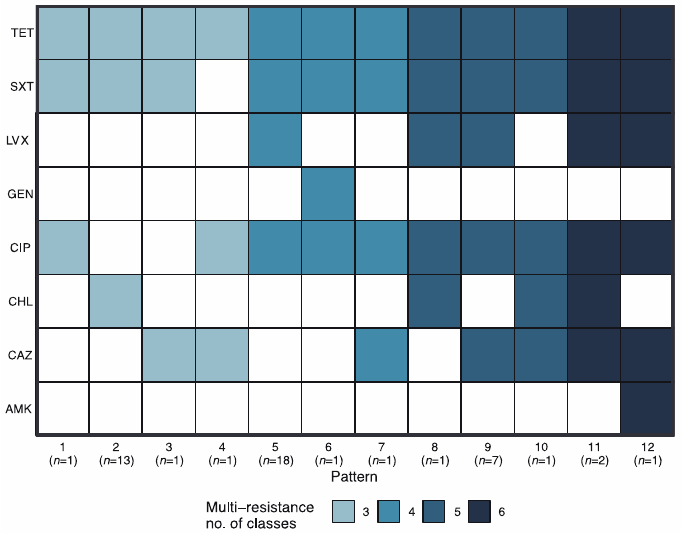
Figure 2. Multidrug resistance patterns detected in E. coli isolates. The colored boxes indicate resistance to each antibiotic (ordinate) creating a unique pattern (abscissa). The color gradient represents the number of resistances and n indicates the number of isolates belonging to each pattern. TET-resistant strains represented 76% of the E. coli isolates (114 of 150) (Figure 3).